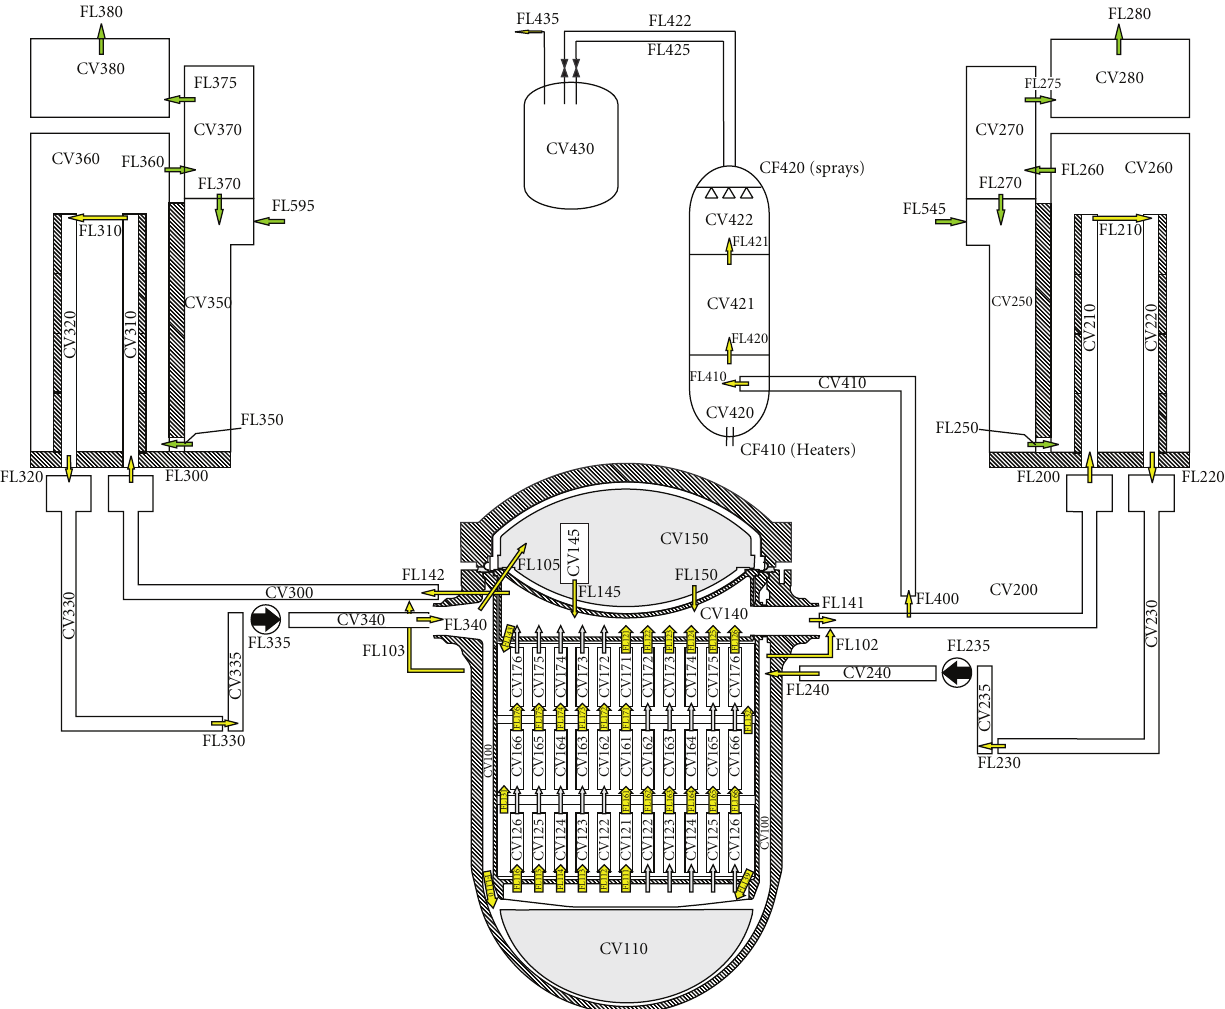
Figure 5: MELCOR nodalisation scheme of reactor, coolant circuits, and SGs (cross connection inside the core not shown).